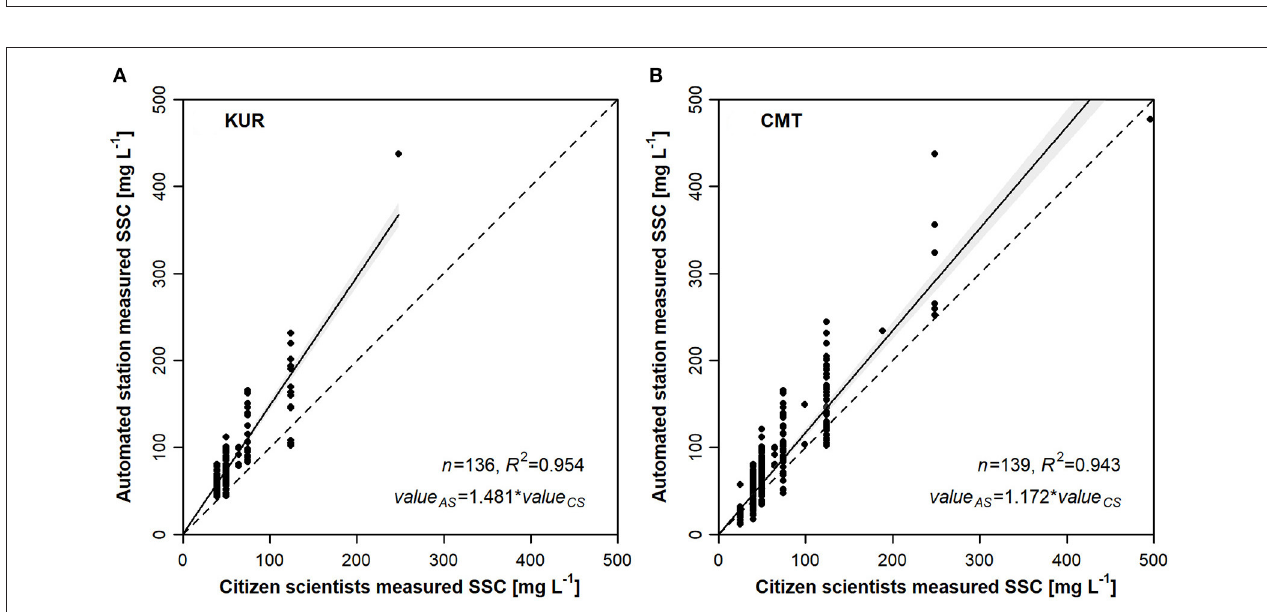
FIGURE 2 | Relationship between suspended sediment concentrations (SSC) (mg L − 1 ) and turbidity measurements using (A) turbidity tubes (Tu) at the six monitoring sites and (B) automated station (AS) at two monitoring sites (KUR and CMT) in the Sondu-Miriu river basin, Kenya.